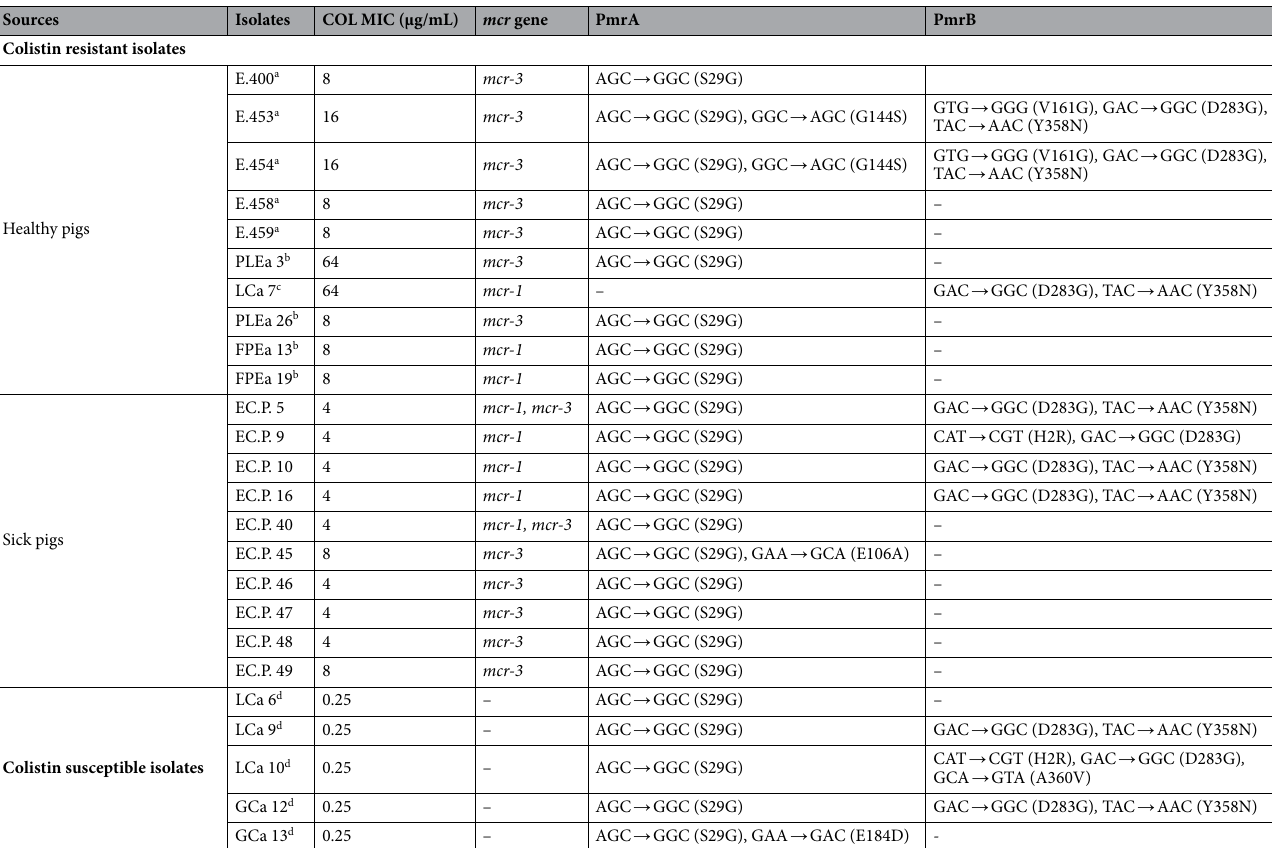
Table 3. The presence of mcr genes and amino acid substitution in PmrAB among colistin-resistant isolates from pigs (n = 25) in Thailand between 2007 and 2018. a Fattening pigs, b Piglets, c Lactating and d Gestating sows.